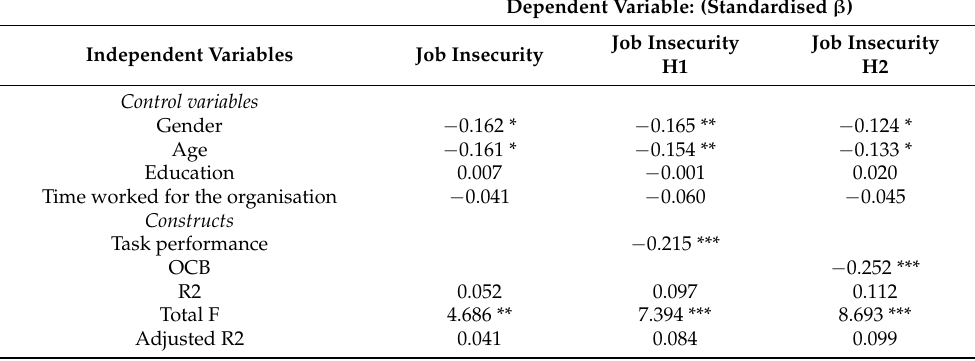
Table 8. Multiple regression